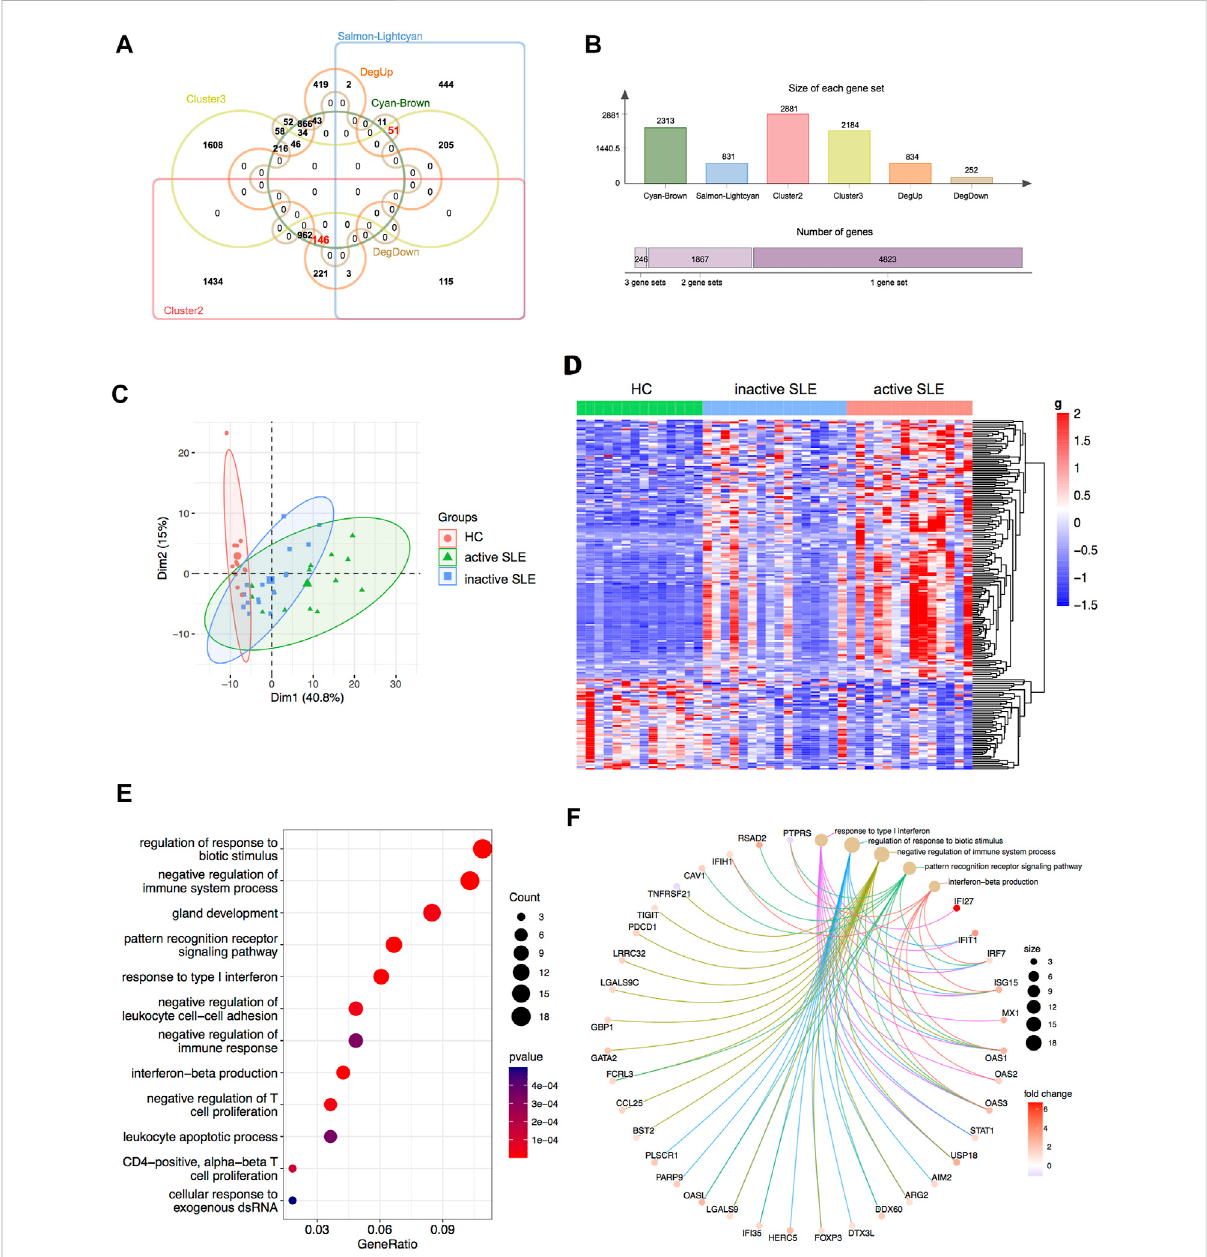
FIGURE 5 Identi fi cation of thecandidate keygenes. (A,B) The venn diagram (A) and bar plot (B) showed thenumber of genes in thesalmon-lightcyan and cyan-brown modules, Cluster 2 and 3, upregulated and downregulated DEGs gene sets. (C,D) The PCA (C) and heatmap (D) analysis of the selected genesinHC,inactiveandactiveSLEpatients. (E,F) Dotplot (E) andnetworkplot (F)